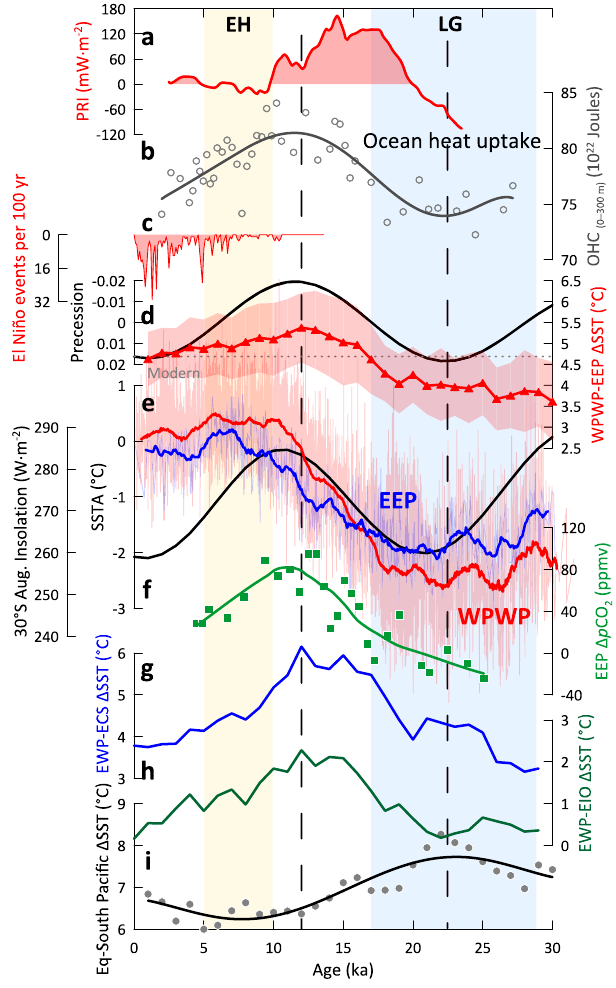
Fig. 2 | Thermal variations oftheIndo-Paci fi c warm pool and ElNiño-Southern Oscillation-like evolution since 30ka. a Variations of planetary radiative imbal- ance(PRI) 61 . b 0 – 300m oceanheat content (OHC) recordfrom coreKX22-4 in this study (Supplementary Fig. 17). c El Niño events recorded in lake Laguna Pallcacocha 27 in the eastern equatorial Paci fi c. d Annual zonal sea surface tem- perature difference between the central western Paci fi c warm pool (WPWP) and eastern equatorial Paci fi c (EEP) (red) and its standard deviation (red shade), the dotted horizon line represents the modern annual mean sea surface temperature differencebasedontheWorld OceanAtlas2018seasurfacetemperature data,and black solid line denotes orbital precession 85 . e Annual mean sea surface tempera- ture anomaly (SSTA) stacks in the central western Paci fi c warm pool (red, Mg/Ca) and eastern equatorial Paci fi c (blue, Mg/Ca and U k ’ 37 , Supplementary Fig. 5) com- putedusingaslidingrectangularwindowof1kyrwidthbySTATNARY1.2,aswellas the late winter insolation at 30°S (black). f Oceanic Δ p CO 2 record from Ocean Drilling Program Site 1238 in the eastern equatorial Paci fi c 32 . g – i Zonal and mer- idionalheattransfer(seasurfacetemperaturegradient)betweentheeasternpartof the warm pool (EWP) and East China Sea (ECS), the eastern part of the warm pool and eastern Indian Ocean (EIO), the equatorial Paci fi c (Eq) and South Paci fi c (Supplementary Fig. 9). Yellow and blue bars indicate the early Holocene (EH) and last glacial (LG), respectively. The vertical dash lines denote the precession max- imum and minimum at ~22 and ~12ka,